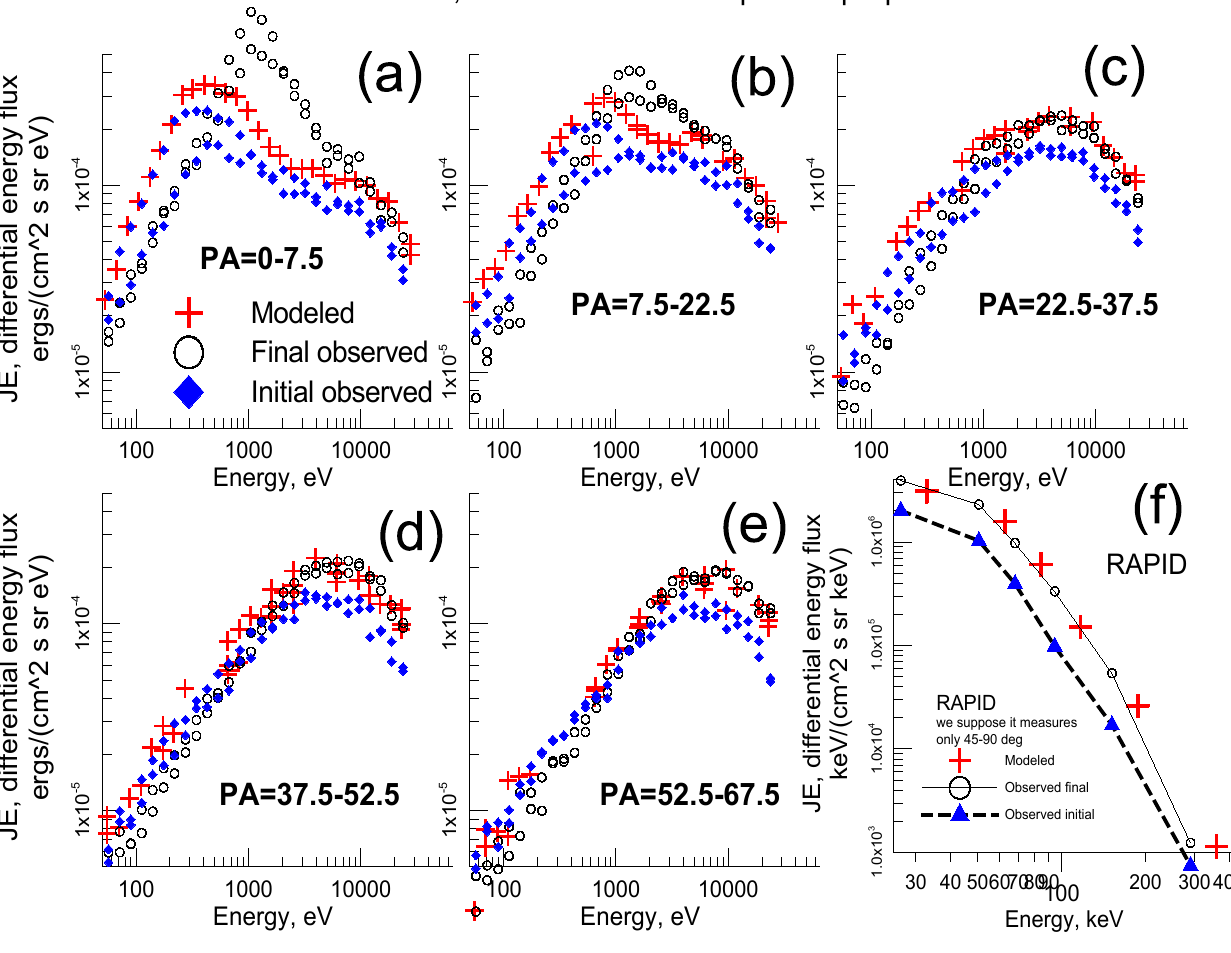
CLUSTER 1 Ininital 3 spin averaged 3:26:31-39 compared with final 3:26:43-51